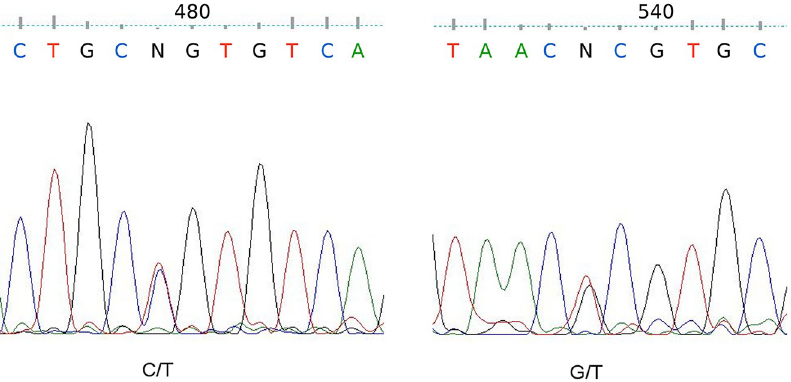
Fig 3. The heteroduplex Y (C/T) at nt 538 of the ITS2 fragment observed in 9 Anopheles sundaicus s.l. samples from Bangka-Belitung Province showing evidence of natural species